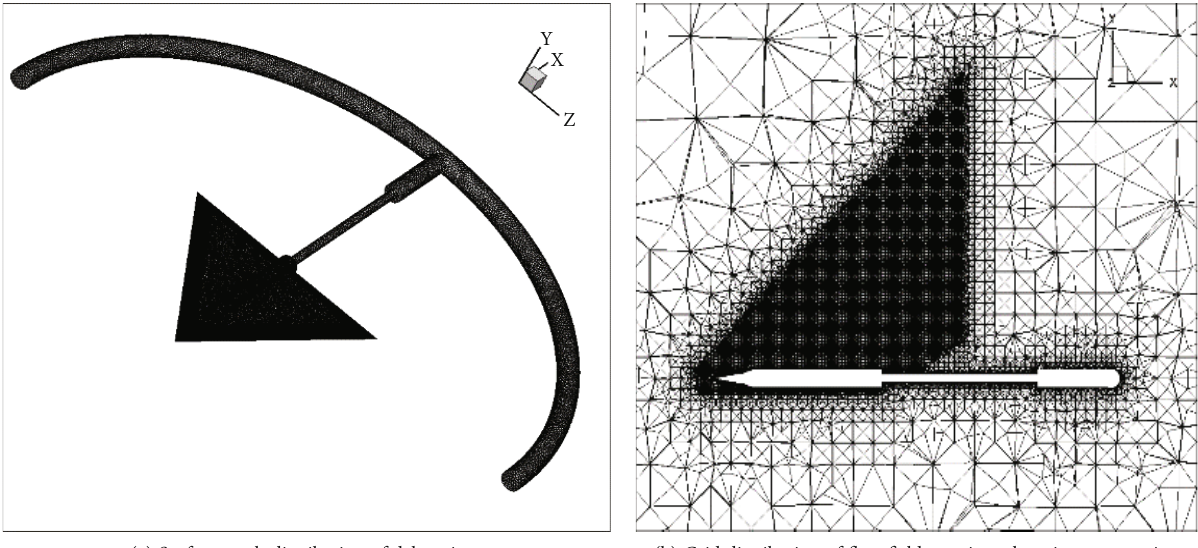
Figure 5: Delta wing meshing